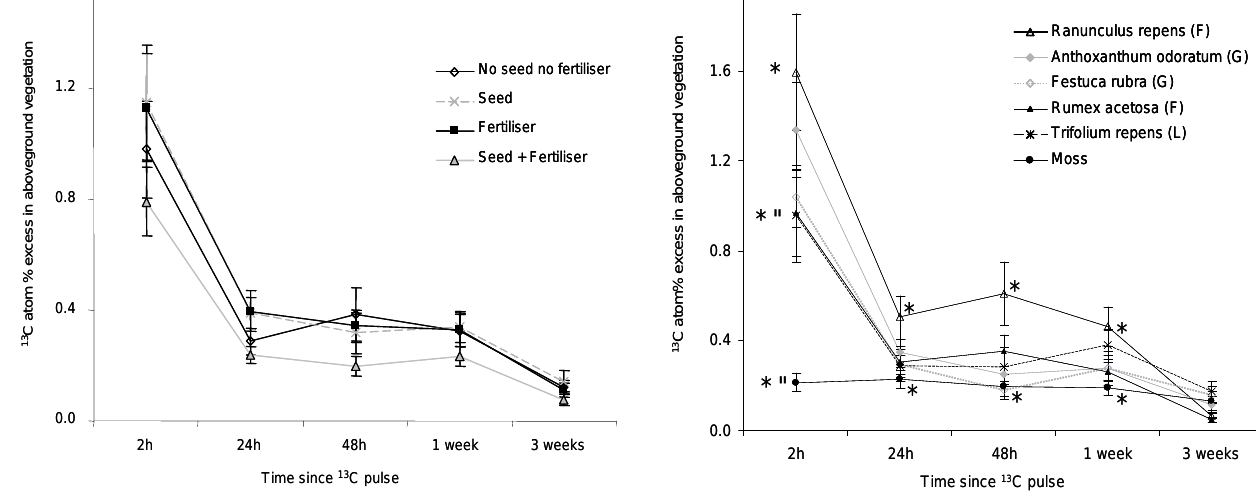
fungal PLFA. One week after the pulse, 13 C enrichment in PLFAs had declined to similar levels as at 2 h after pulse la- belling the vegetation, except for the fungal PLFA 18:2 ω 6,9 which showed significantly higher enrichment then all other PLFAs ( F 7 , 42 = 32.74, P < 0.0001). Restoration manage- ment had no effect on the average abundances of soil bac- teria, fungi, actinomycetes and AMF across the pulse-chase sampling campaign (fertiliser F 1 , 42 = 0.46, P = 0.50; seed addition F 1 , 42 = 0.10, P = 0.76), but abundances were